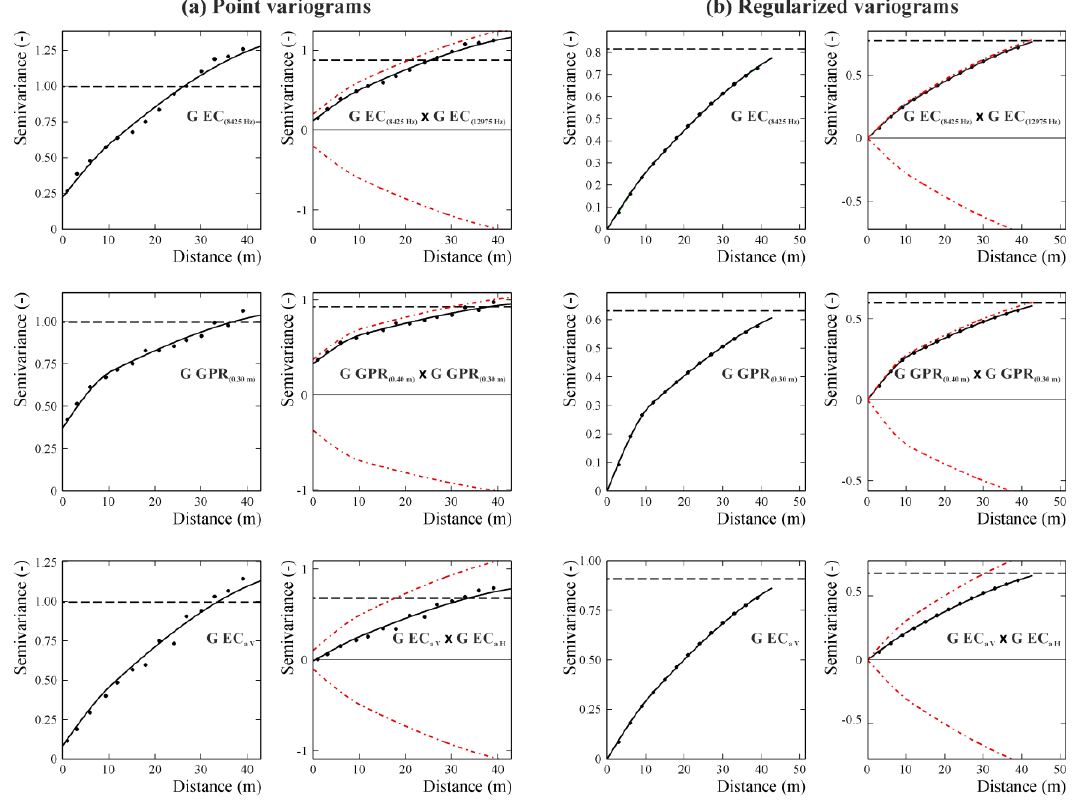
Figure 2. Examples of point ( a ) and reguralized ( b ) auto- and cross-variograms of the Gaussian variables of EC a(- Hz) (apparent electrical conductivities measured by the GEM Profiler), EC a H and EC a V (apparent electrical conductivities measured by the EM38DD in horizontal and vertical polarization) and GPR signal amplitude at different depth slices. The experimental values are the plotted points and the solid lines are of the model of coregionalization. The dash-dotted lines are the hulls of perfect correlation and the dashed lines are the experimental variances.